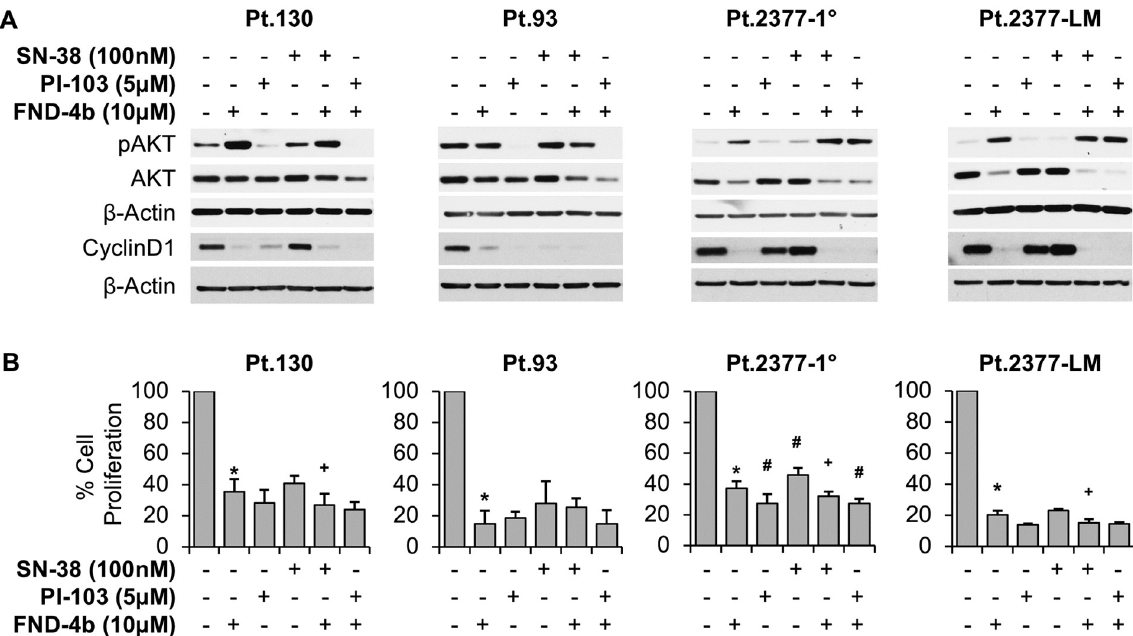
Fig 5. Cell proliferation of PDX-derived CRC cell lines treatment combinations. (A) Western blot analysis of PDX-derived CRC cell lines treated with 10 μ M FND-4b, 5 μ M PI-103, and 100nM SN-38, alone and in combination versus untreated control (media alone) for 24h duration. β -actin was used as a loading control. The images are representative of three independent experiments. In all CRC cell lines mono- or dual- treatment with FND-4b resulted in decreased cyclin D1 expression. (B) SRB Cytotoxicity Assays of PDX-derived CRC cell lines treated with 10 μ M FND-4b, 5 μ M PI-103, and 100nM SN-38, alone and in combination for 144h duration. Graphic representations are the mean ± SD plotted as a percentage relative to untreated control; each measurement was performed with 5 replicates. � p < 0.0001 vs. control, #p < 0.01 vs. FND-4b alone, and +p < 0.05 vs. SN-38